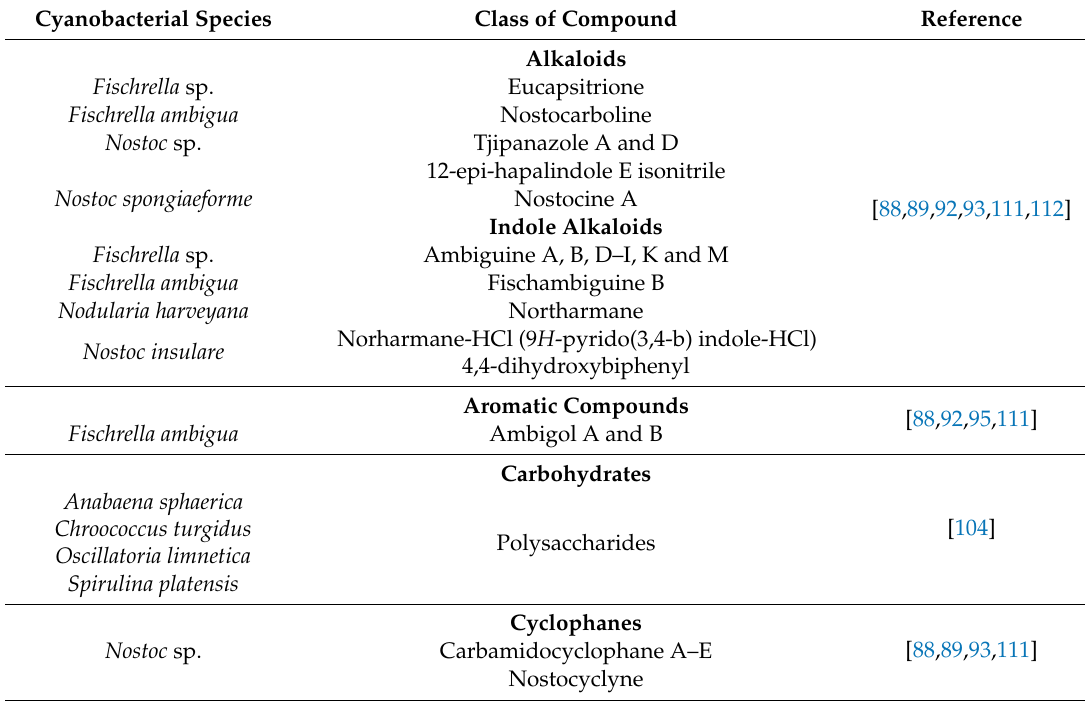
Table 1. Antibacterial compounds from